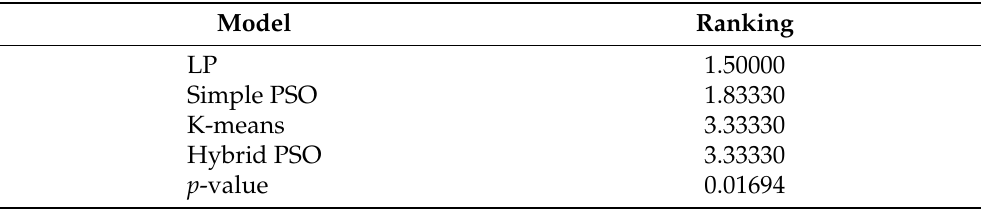
Table 19. The results from the Friedman test: the ranking applied to the arithmetic mean values and the sums of the distances between the gateways and the IoT